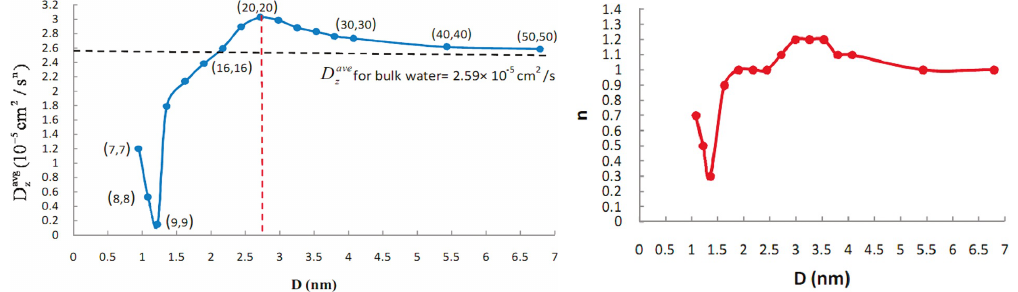
Figure 7. ( Left ) Variation of the average axial diffusion coefficient, D ave z , of water as a function of the diameter of the CNT. ( Right ) Variation of n, the exponent which defines the diffusion mechanism (see Equation (2)), as a function of the CNT diameter. Reprinted with permission from Reference [127]. Copyright © 2011 American Chemical